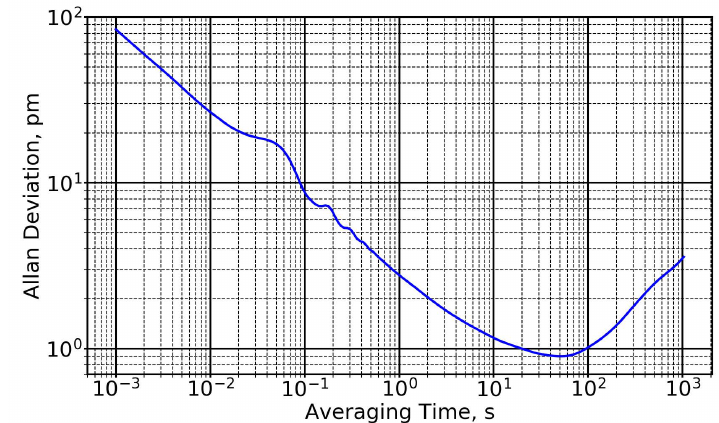
Figure 3. Semiconductor-laser tracking frequency gauge (TFG) precision in picometers vs. averaging time in seconds, determined by measuring the half-meter optical path-length difference of a Michelson interferometer using two TFGs simultaneously, operated at 1560 nm with a common optical path (from [73]). The demonstrated stability (Allan deviation less than 3pm for averaging times ranging from about 1 s to about 1000 s) implies that X-ray calibrations need not be repeated more often than every 10 to 20 min; given operation in a cavity of modest finesse (as in Figure 4), the calibration interval extrapolates to 10 days.